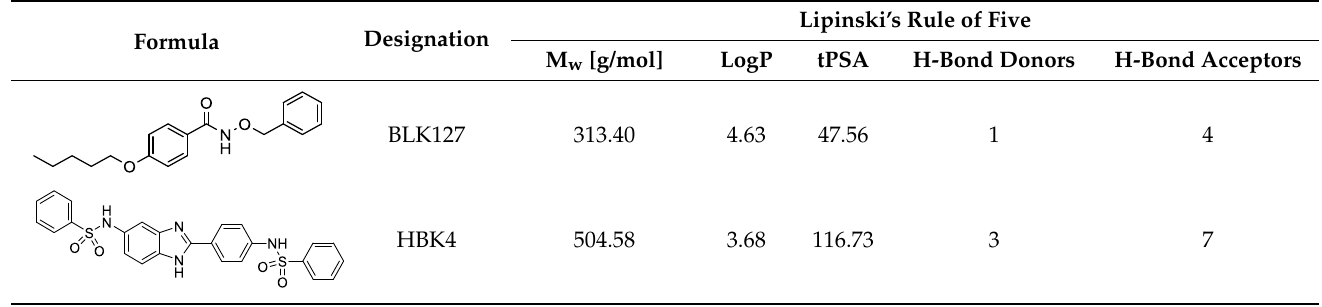
Table A1. Lipinski’s rule of five descriptors for the two compounds of interest, including molecular